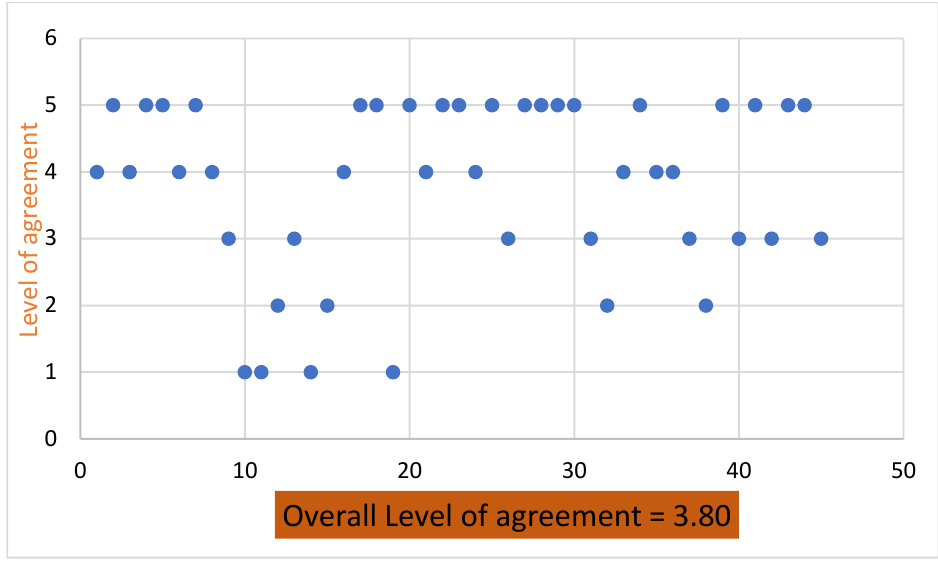
Figure 10. Level of agreement for the effectiveness of mangrove forests in reducing coastal hazards.